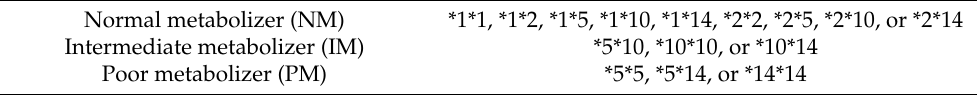
Table 2. Categorization of CYP2D6 gene phenotypes based on genotypes. Normal metabolizer